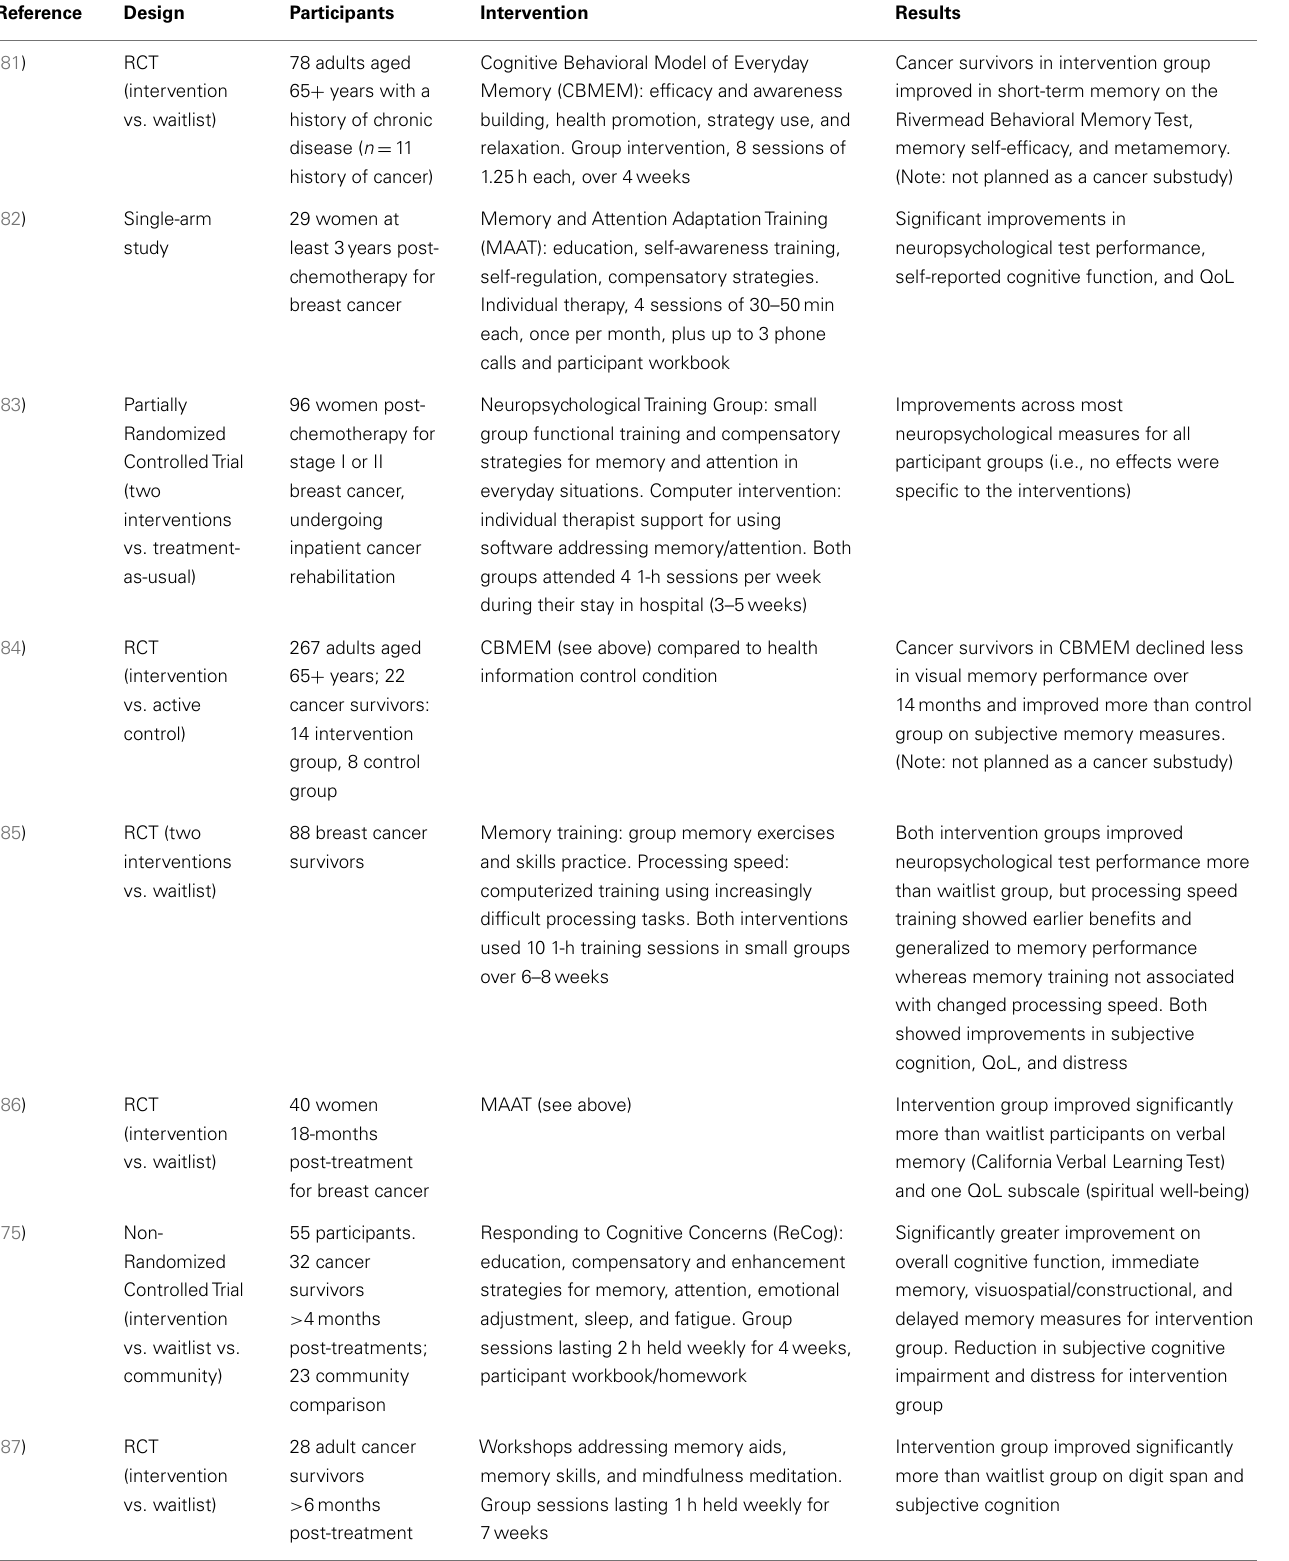
Table 1 | Psychological intervention studies addressing cognitive impairment in cancer survivors .